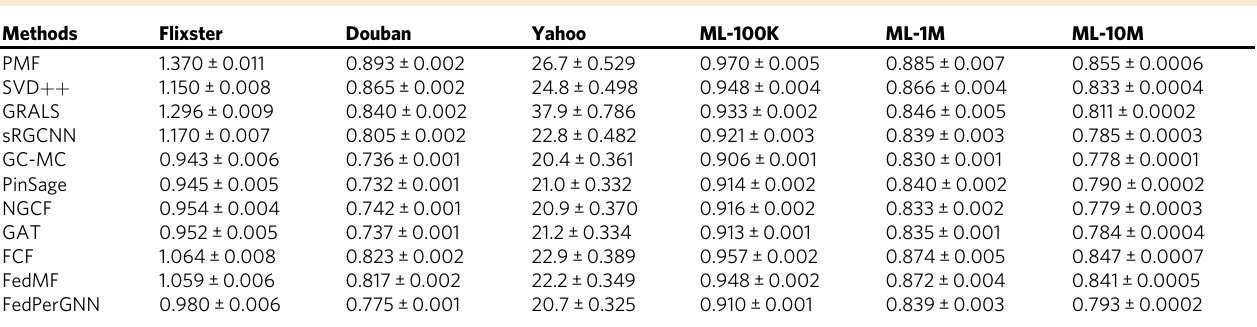
Results of FedPerGNN and the best-performed baseline are in bold. The advantage of FedPerGNN over other SOTA privacy-preserving personalization methods FCF and FedMF is signi fi cant ( p <0.1). FedPerGNN also achieves comparable performance with other centralized GNN-based personalization methods, and there is no signi fi cant difference between FedPerGNN and the best-performed method on Yahoo ( p >0.1).